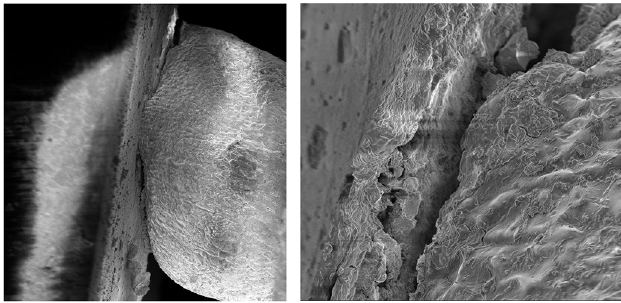
Fig. 16. SEM image of the corner solder ball of the package